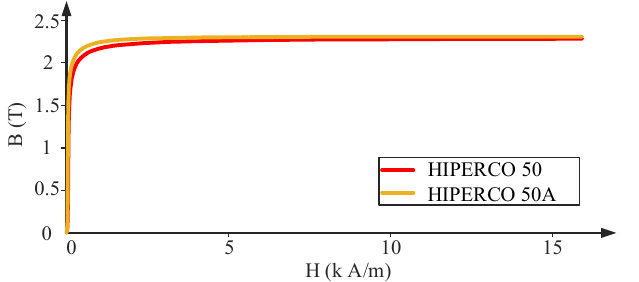
Figure 1. Comparison of the magnetic properties of HIPERCO ® 50/50A [22].